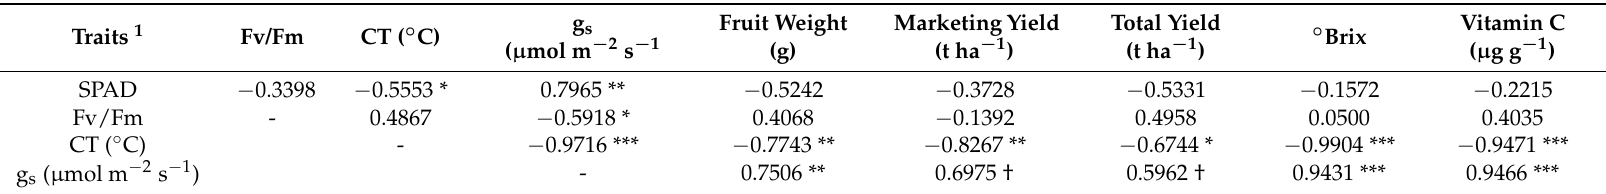
Table 5. Correlation coefficients (r) and significance levels between physiological traits and yield and quality of tomato under regular irrigation (WI), n = 8. Traits